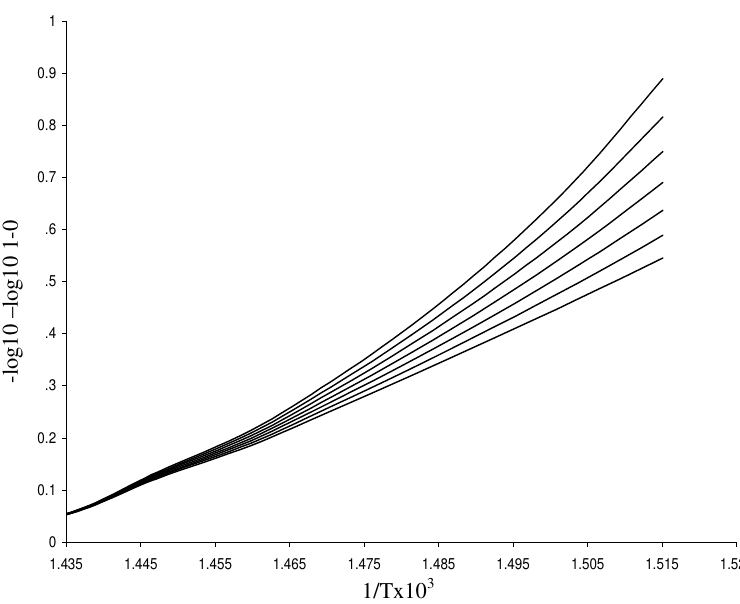
–log 1-a and reciprocal of temperature from TGA data for R 10 10